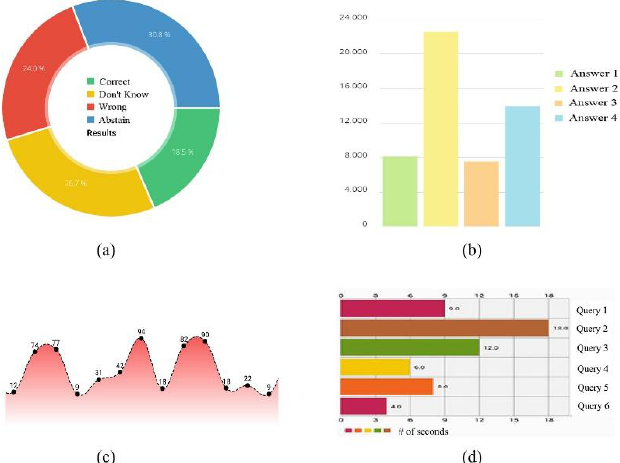
Figure 5. Research results visualization